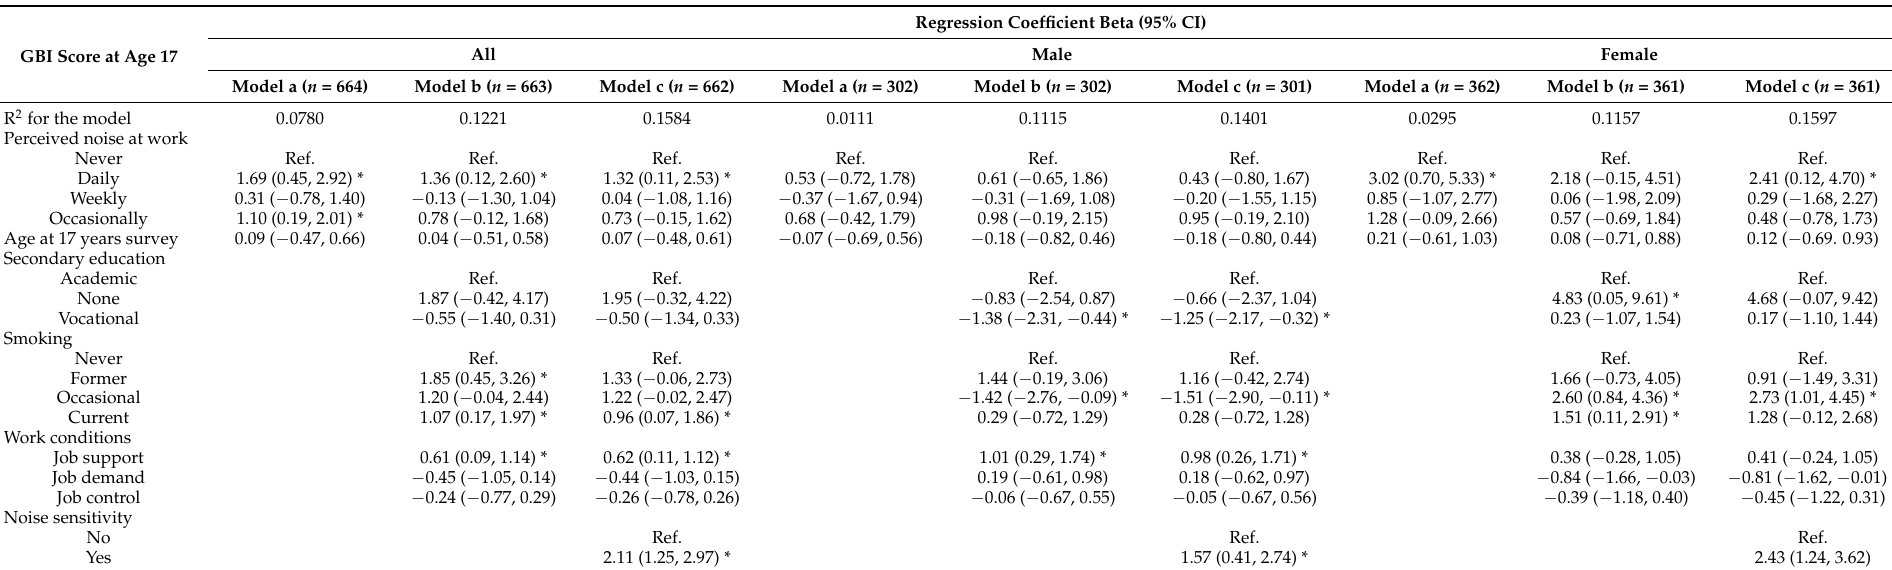
Table 3. Linear multivariable regression models of the association of depressive symptoms at age 17 using the GBI scale with perceived occupational noise exposure and selected covariates in young